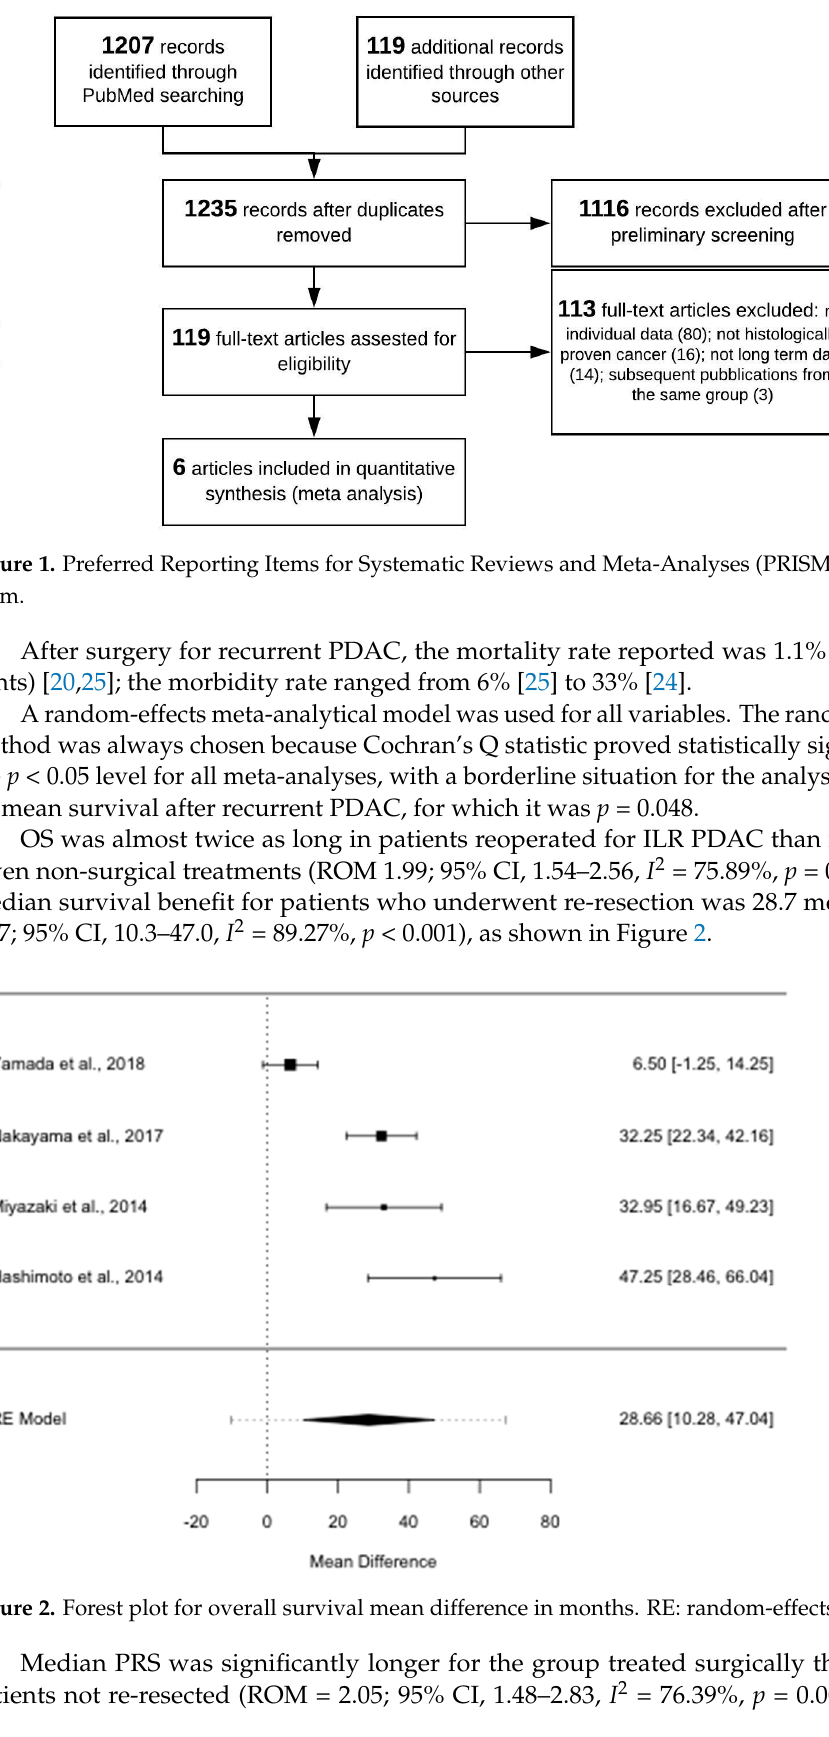
Figure 3. Forest plot for post recurrence survival mean difference in months. RE: random-effects. The cumulative meta-analysis demonstrated that the benefit after pancreatic re-re- section settles very quickly for both OS and PRS. Funnel plots provided some evidence of